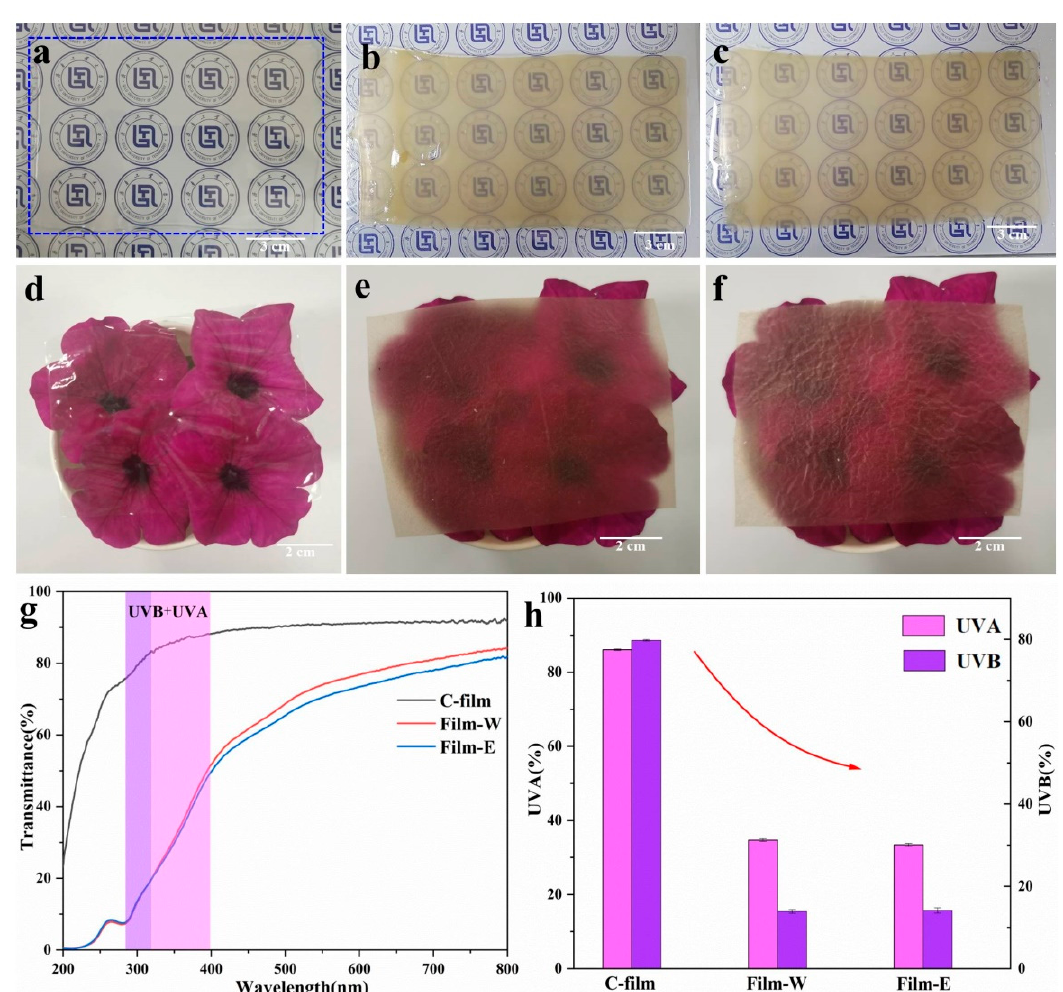
Figure 3. Optical photographs of cellulose-based gels ( a , C gel; b , hydrogel; c , alcogel) and cellulose-based films ( d , C-film; e , Film-W; f , Film-E); ( g ) UV–Vis spectra, ( h ) UVA and UVB of C-film, Film-W and Film-E.